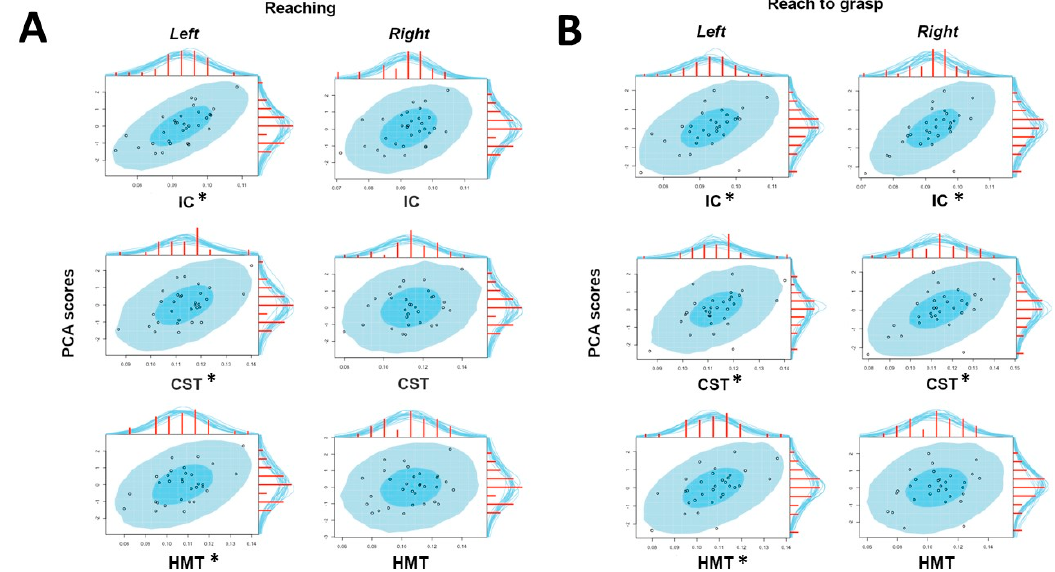
Figure 5. graphical representation of the Bayesian correlations between HMOA values (x-axis) and PCA components (y-axis) obtained for both tasks (Panel A: reaching; Panel B: reach-to-grasp) for the considered tracts (IC, CST, HMT) in both hemispheres (left, right). *: significant correlation.